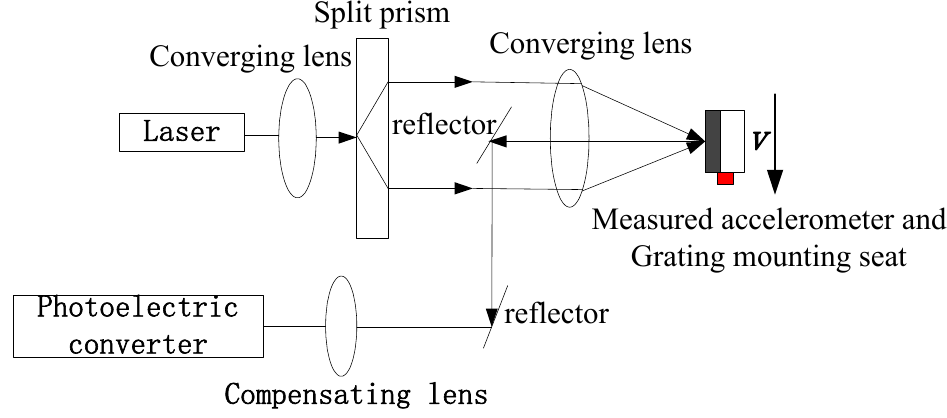
Figure 4. The principle diagram of the differential laser Doppler interferometer.